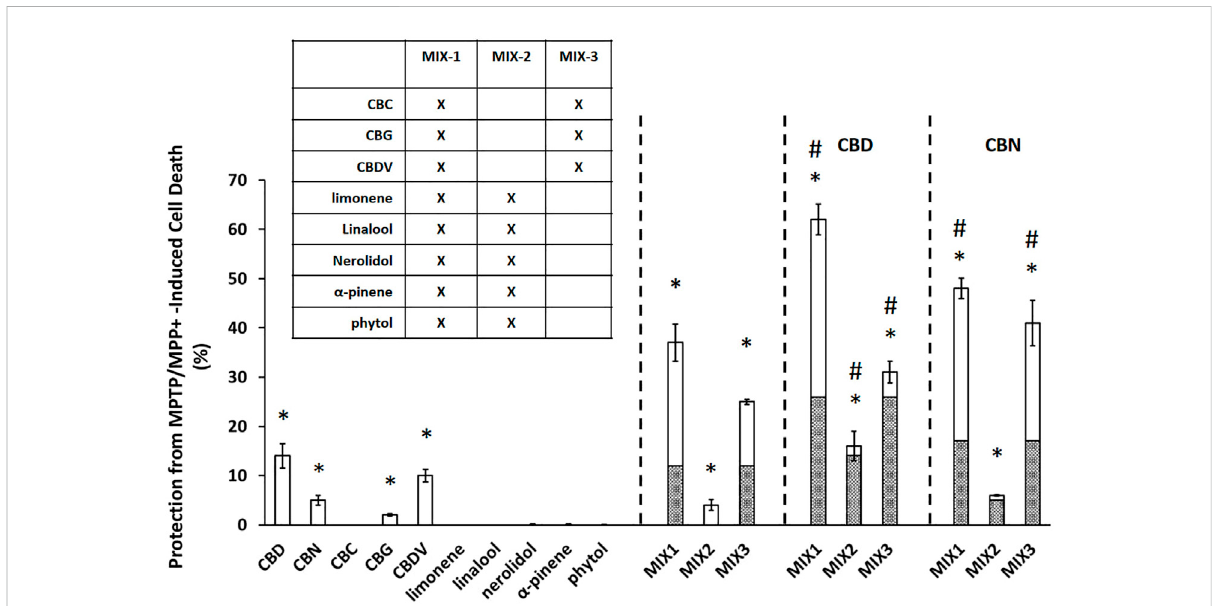
FIGURE 1 Cannabinoids produce signi fi cant neuroprotection in MPTP/MPP + assay. Data are presented as the percent protection from MPTP/MPP + cell death evaluated based on the MTT cell viability assay, where the experimental value is normalized relative to the vehicle control. An asterisk * indicates a p -value < 0.05 for the replicates relative to their respective vehicle control replicates. MIX-1, MIX-2, and MIX-3 tested without or with the addition of a major cannabinoid (CBD or CBN) a hashtag # represents p < 0.05 major cannabinoid vs. native mixture. Calculated (hashed shading) prediction of ef fi cacy based on the sum of the ef fi cacy of each ingredient measured separately and Measured (open shading) ef fi cacy are shown. Each data point in the fi gure represents the mean ± the standard deviation of twenty-four experimental results obtained at 10 µM of each major or minor cannabinoid and terpene (alone or in equimolar mixtures as described in the inset table in Panel). Twenty-four experimental results were obtained by repeating eight independent experiments three times on three different days ( ” 8 × 3 ”